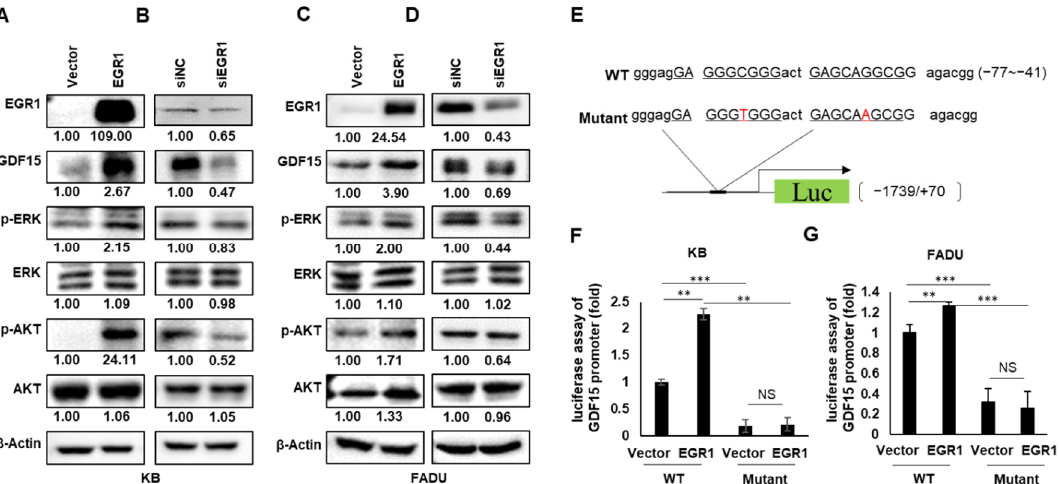
Figure 4. EGR1 induces the expression of GDF15 as its transcription factor. Cells were transfected with an EGR1 overex- pression vector ( A , C ) or EGR1 siRNA ( B , D ), followed by Western blot analysis. After transfection, the levels of GDF15, p - ERK, ERK, p -AKT and AKT were evaluated by Western blots. ( E ) EGR1 binding region ( − 77~ − 41) of GDF15 promoter ( − 1739/+70) with point mutations (The T and A marked in red) are described. ( F , G ) The EGR1 overexpression vector was cotransfected with the wild-type GDF15 promoter or the mutant GDF15 promoter into KB and FADU cells. At 24 h after transfection, cells were lysed and luciferase activity was measured using a luminometer. Differences were considered relevant at p < 0.05 (** p < 0.01, *** p < 0.001). All experiments were repeated at least three times.